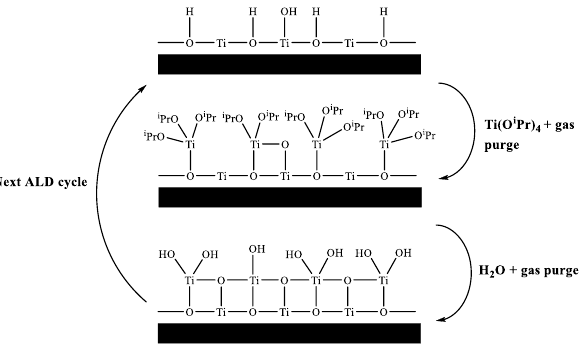
Figure 1. Schematic of ALD growth mechanism using titanium isopropoxide and water.